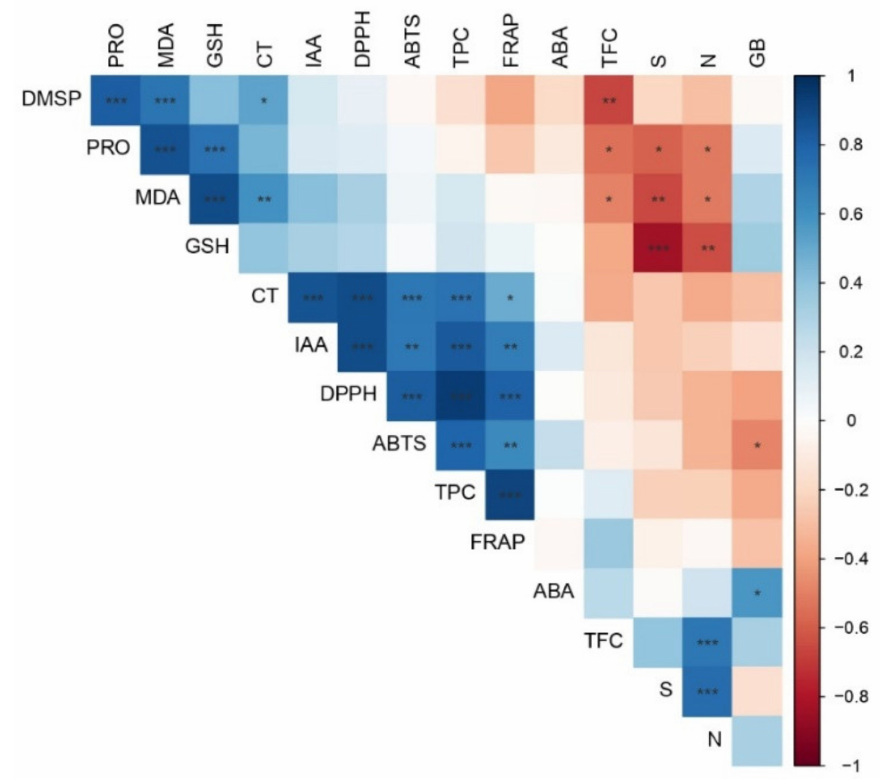
Figure 8. Pearson’s coefficient of correlation matrix of the examined parameters in Q. robur and Q. cerris leaves *. See legend of Figure 6 for abbreviations of parameters. The strength of the correlation is indicated by color saturation. Significance values are indicated as: * p < 0.05; ** p < 0.01; *** p <